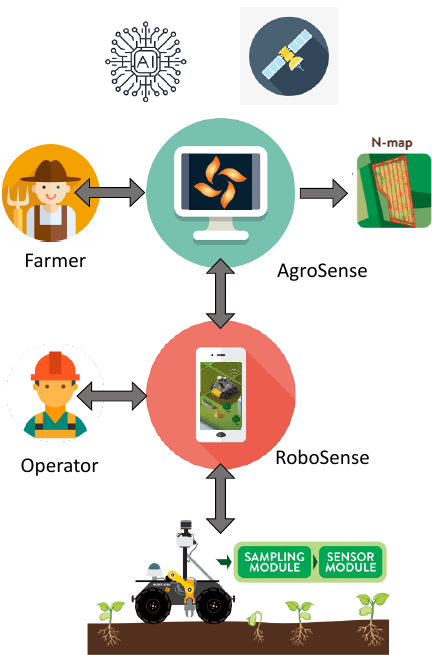
Figure 12. An overview of the system for soil sampling and analysis.